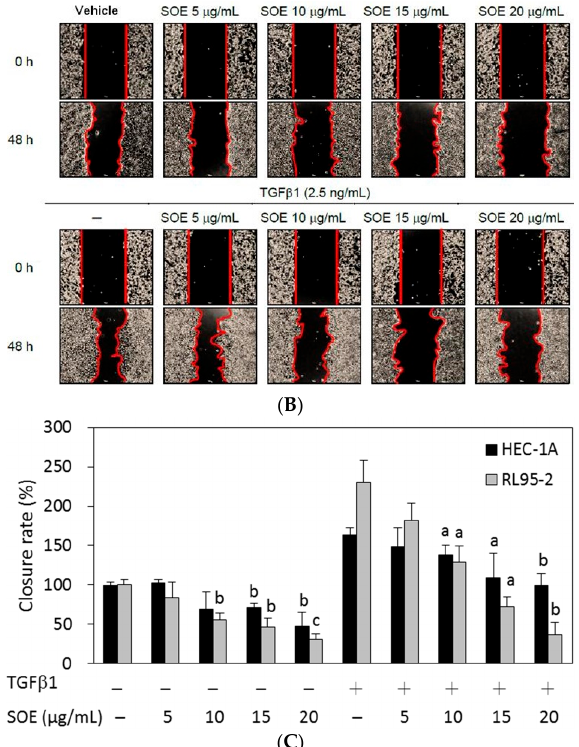
Figure 3. Effects of SOE dose on the motility of endometrial cancer cells. ( A ) HEC-1A cells; ( B ) RL95-2 cells; and ( C ) closure rates of both cell lines. Cancer cells were cultivated with a Culture Insert-2 Well (ibidi GmbH, Munich, Germany) for 24 h. After the culture insert was removed, DMEM with specified SOE concentrations was added, with or without TGF β 1 (2.5 ng/mL) stimulation, and the cells were then incubated. Photomicrographs of culture plates were directly obtained using a phase-contrast microscope (magnification 20×). Closure rate is defined as 100% without TGF β 1 induction and without SOE treatment. Three independent experiments were conducted; results are expressed as mean ± SD. A significant difference from the respective vehicle, according to Student’s t -test, was indicated as “a” for p < 0.05; “b” for p < 0.01, and “c” for p < 0.001.